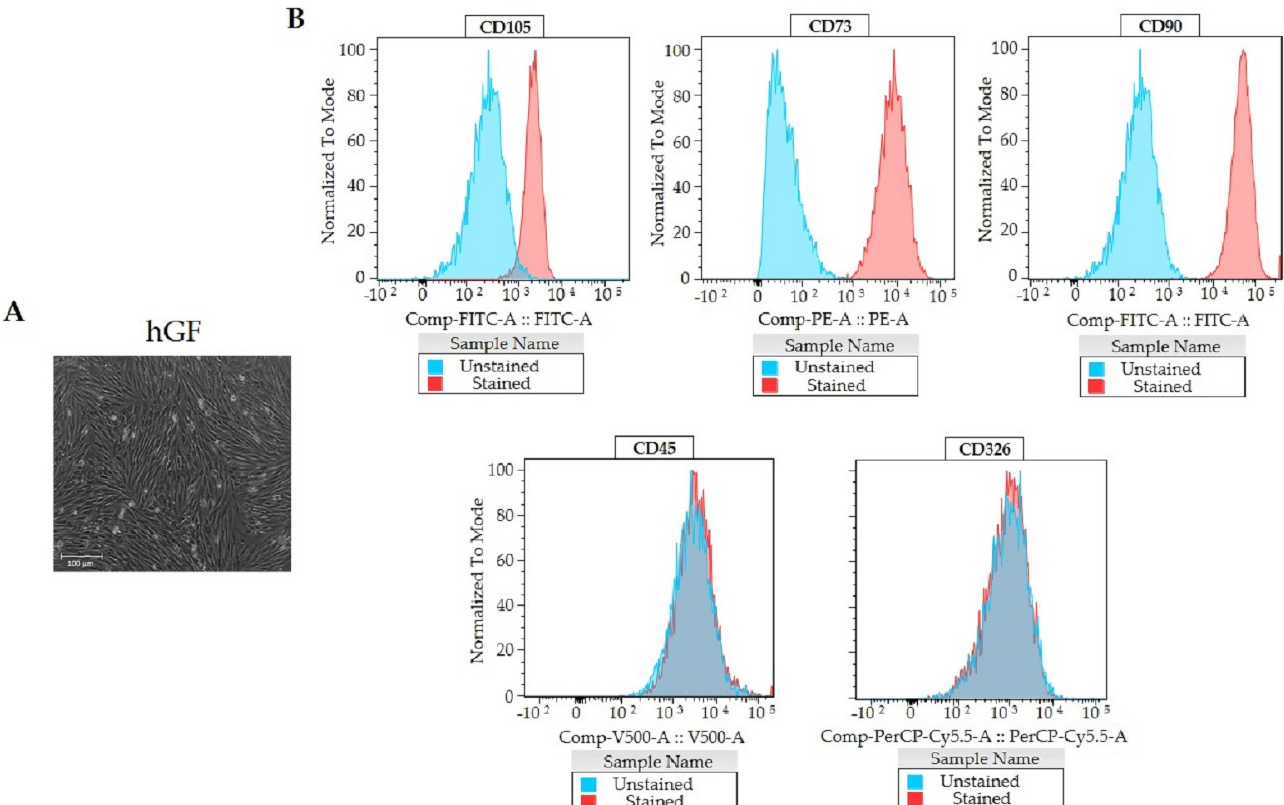
Figure 2. ( A ) Representative phase-contrast micrograph of isolated hGF taken by PAULA Smart Cell Imager. ( B ) Characterization of hGF. Representative graphs of CD105, CD73, CD90, CD45, and CD326 expressions evaluated by cytometric analysis.